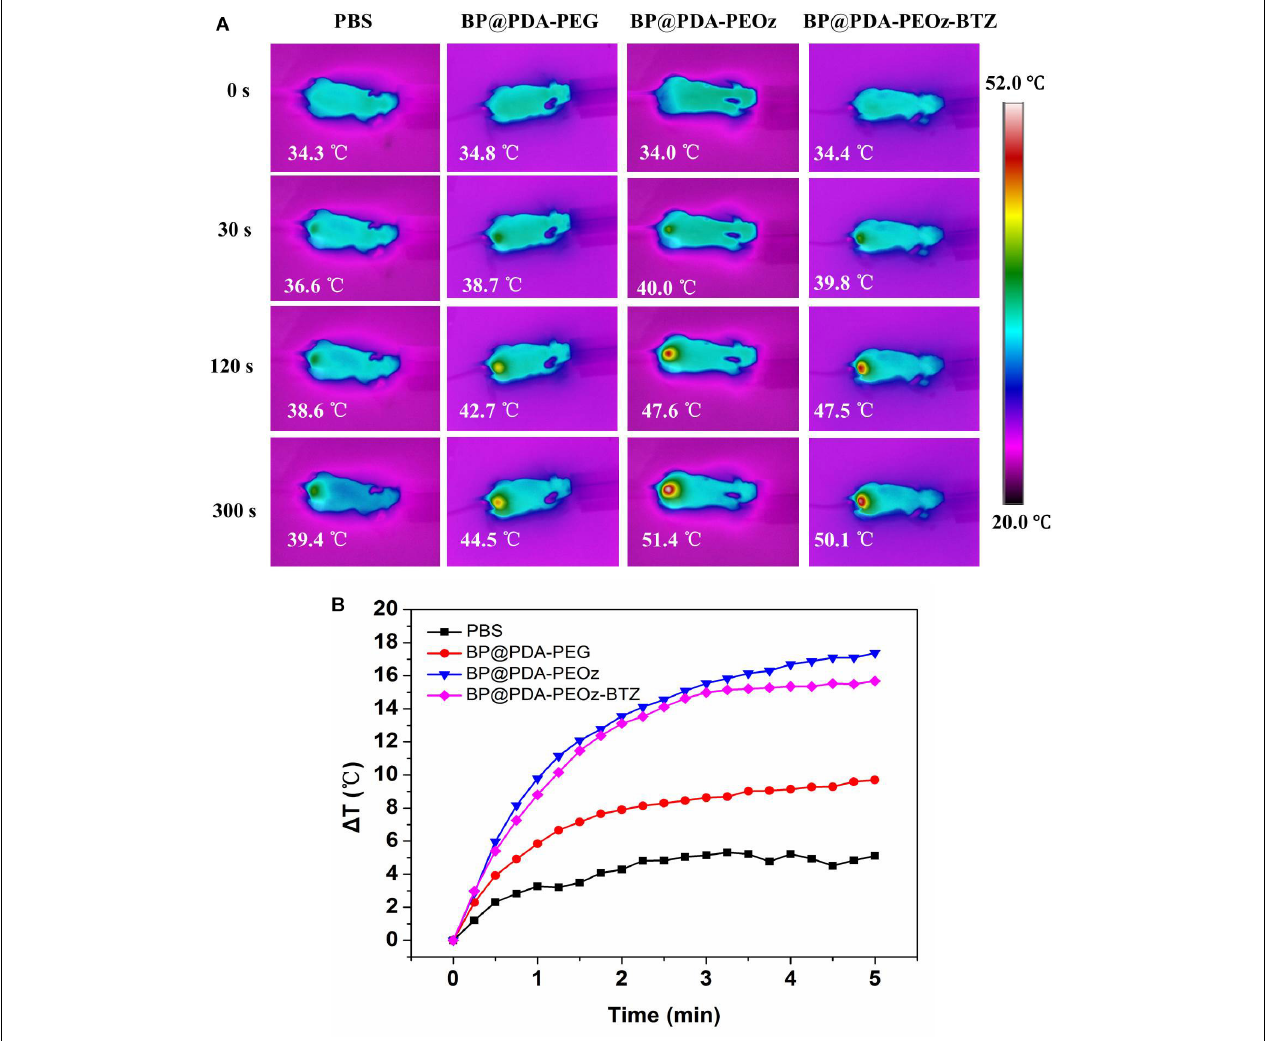
FIGURE 9 | (A) In vivo IR thermal images of tumor-bearing mice after tail intravenous injection of PBS, BP@PDA-PEG, BP@PDA-PEOz, and BP@PDA-PEOz-BTZ for 24 h, followed by exposure to 808 nm laser irradiation (1.5 W/cm 2 , 5 min). (B) Time-dependent temperature increase of MCF-7 tumor-bearing mice recorded by an IR camera under 808 nm laser (1.5 W cm − 2